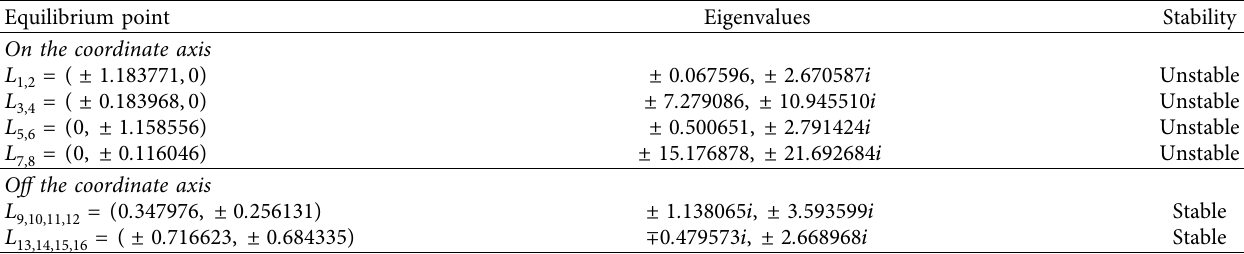
Table 1: Equilibrium points, eigenvalues, and stability status when b � 0 . 58 and a � 0 . 68.